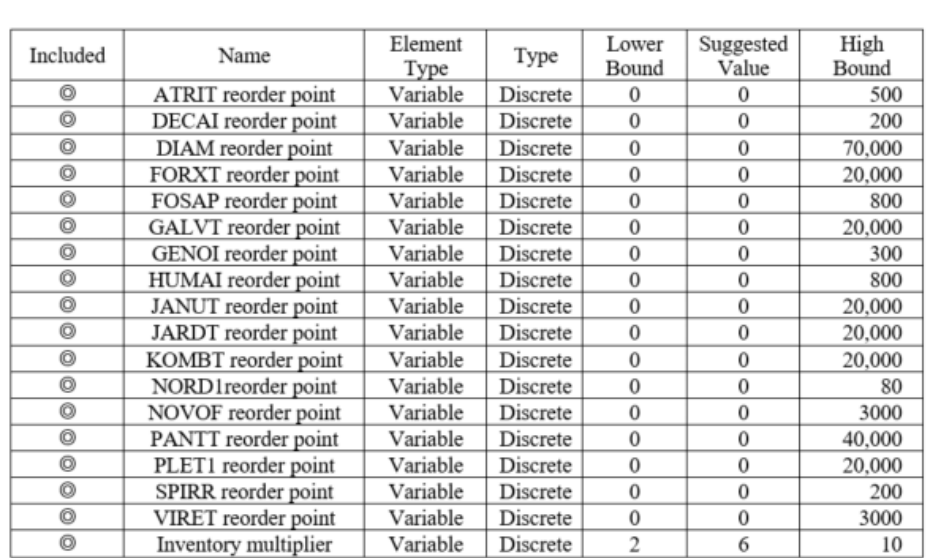
Figure 13. Setting values of the minimal objective function for the 17 drugs in Group 1.